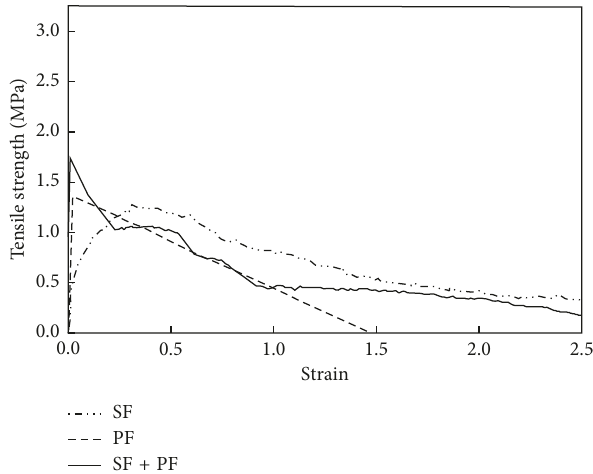
Figure 7: Influence of fiber combination on toughness of concrete mixture at seven-day age.